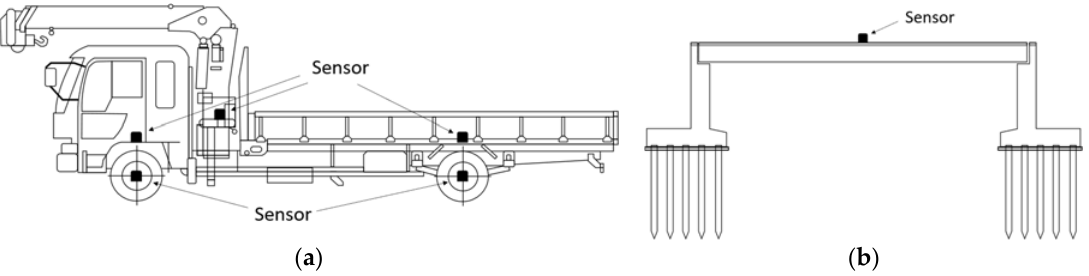
Figure 7. Layout of sensor installation: ( a ) vehicle; ( b ) bridge .